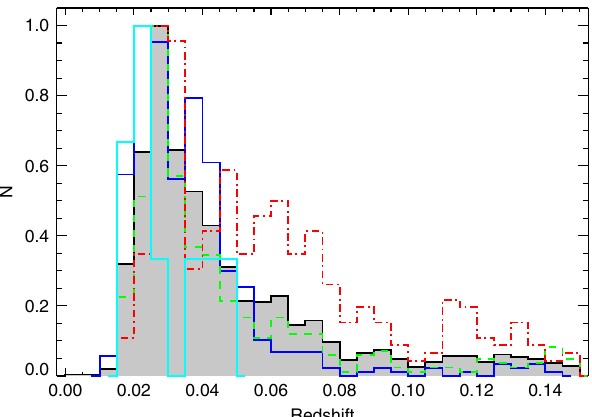
Figure 5 | The redshift distributions of the samples. The grey histo- gram is for the whole MaNGA sample; the blue, red and green histograms show the redshift distributions for the blue, red and green sub- samples, respectively; the nine blue counter rotators are shown in cyan